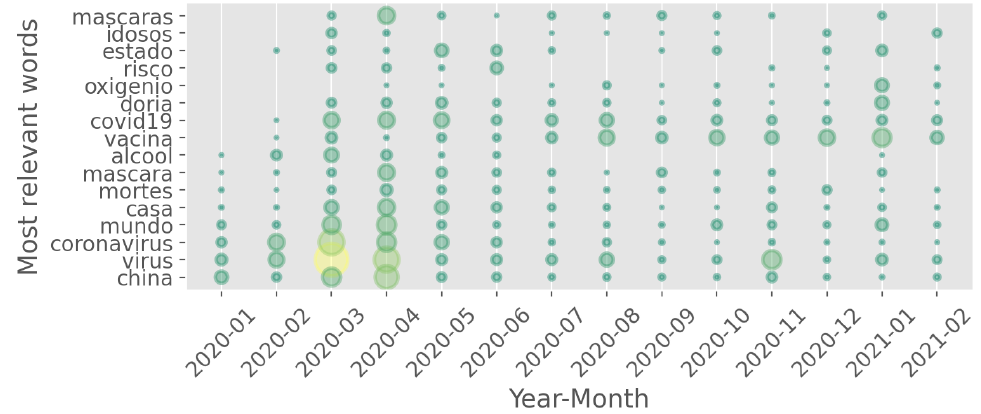
Figure 4. Bubble graph tracking the top 3 words per month featured in the fake news dataset for the